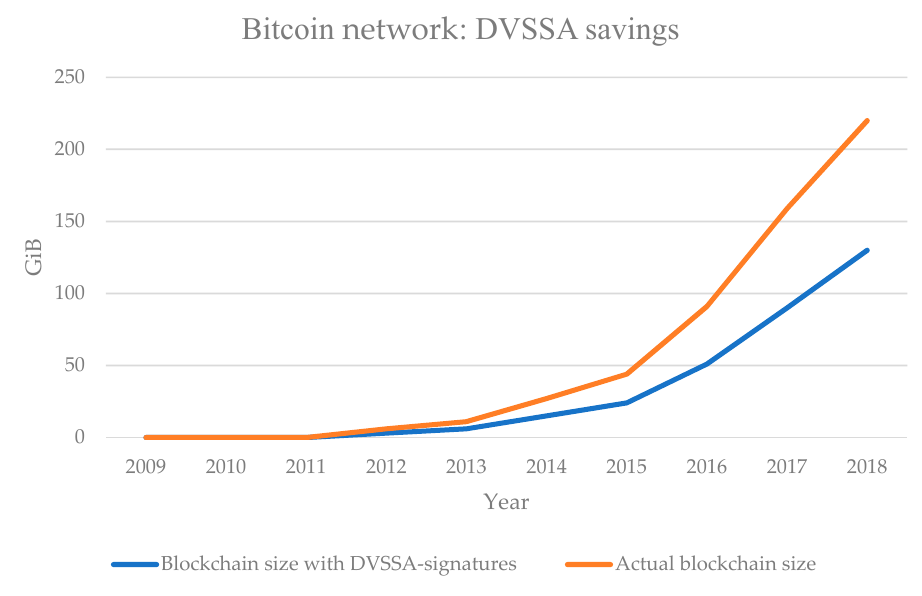
Figure 7. Size of the Bitcoin blockchain with and without DVSSA signatures.